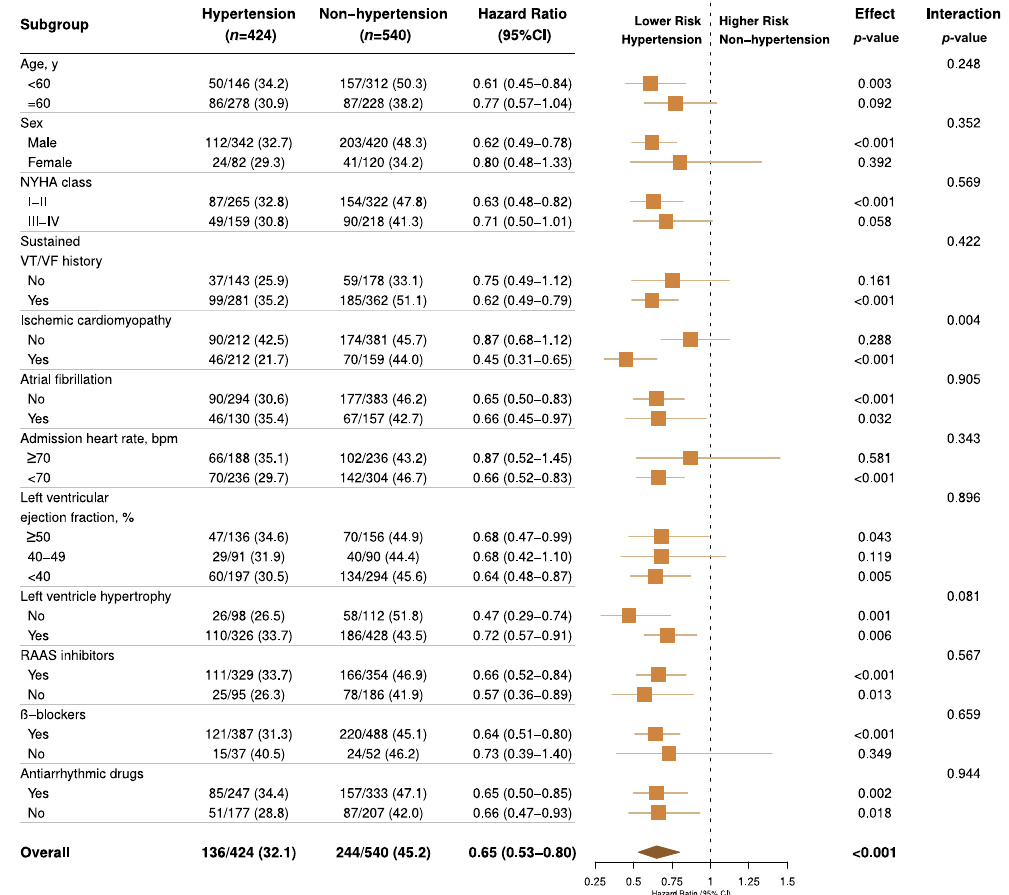
Figure 4. Forest plots for subgroup analyses of primary outcome by hypertension status. Forest plots displaying hazard ratios and 95% confidence intervals for primary VA outcome in subgroups of patients with heart failure by hypertension status. NYHA, New York Heart Association; VT/VF indicates ventricular tachycardia/fibrillation; RAAS, renin-angiotensin-aldosterone system.